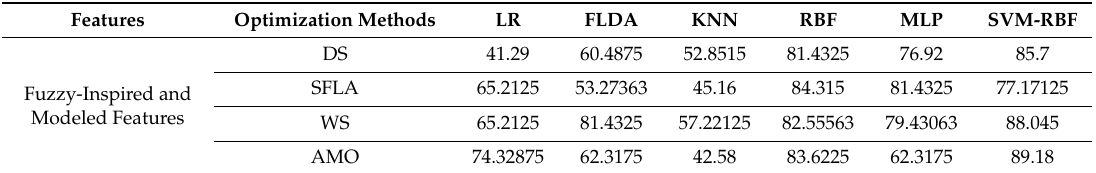
Table 13. Average Performance Index (%) among the classifiers at various optimization techniques with di ff erent features for CVD cases.